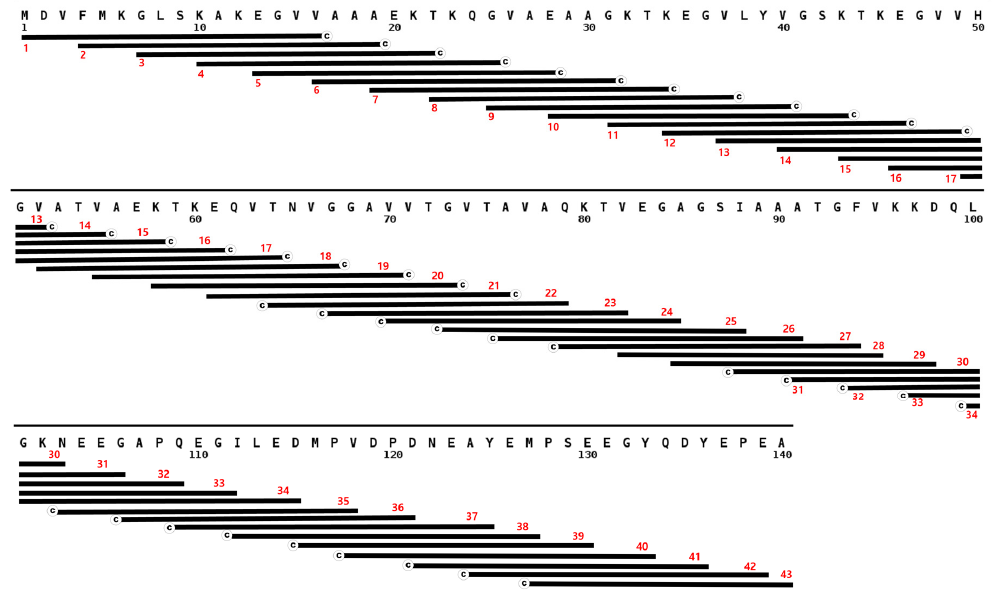
Figure 2. Overlapping α -synuclein peptides aligned with the complete sequence of α -synuclein. The 2 sequence starts with the N-terminus at the upper left corner of the figure and ends with the 140th residue at the lower right corner. Peptides are represented by black bars with cysteine tags and are numbered at the